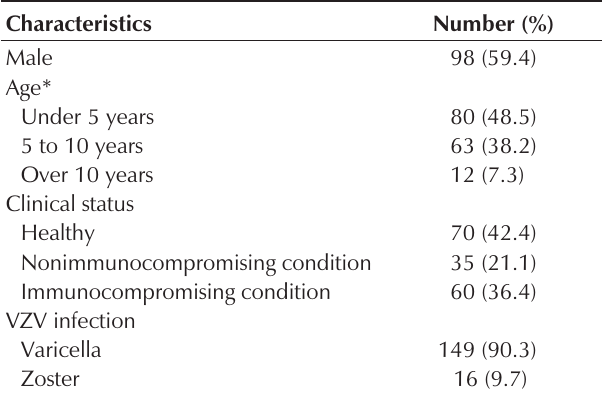
Hospitalizations for varicella zoster infections